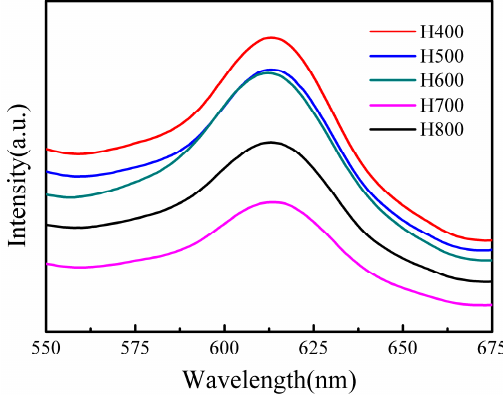
Figure 6. Room temperature PL spectra of BiVO 4 synthesized under different conditions.